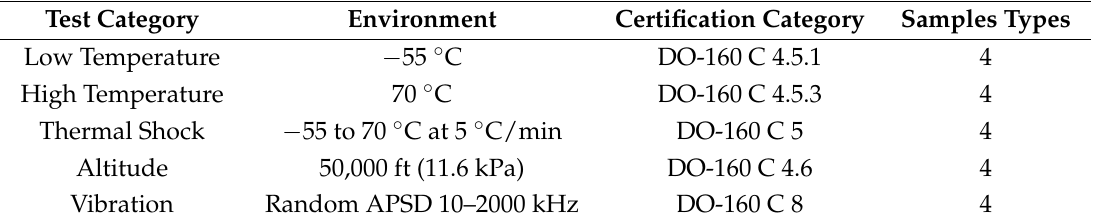
Table 1. Environmental test matrix. Sample type definitions in Section